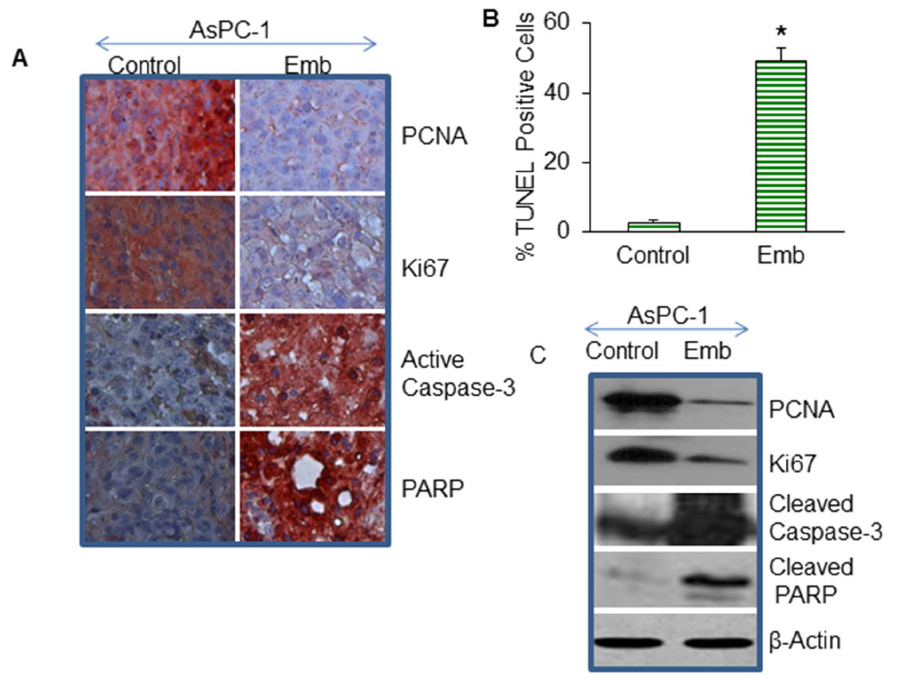
Figure 4. Effects of embelin on cell proliferation and apoptosis. (A), Expression of PCNA, Ki67, caspase-3, and PARP in tumor tissues. Immunohistochemistry was performed to measure the expression of PCNA, Ki67, active caspase-3 and PARP in tumor tissues isolated from control and embelin-treated mice. (B), Quantification of TUNEL positive cells. Apoptosis was measured by TUNEL assay. Data represent the mean 6 S.D. *=significantly different from control, P , 0.05. (C), Effects of embelin on markers of cell proliferation and apoptosis. Western blot analysis was performed to measure the expression of PCNA, Ki67, caspase-3 and PARP in tumor tissues. The b -actin was used as a loading control.